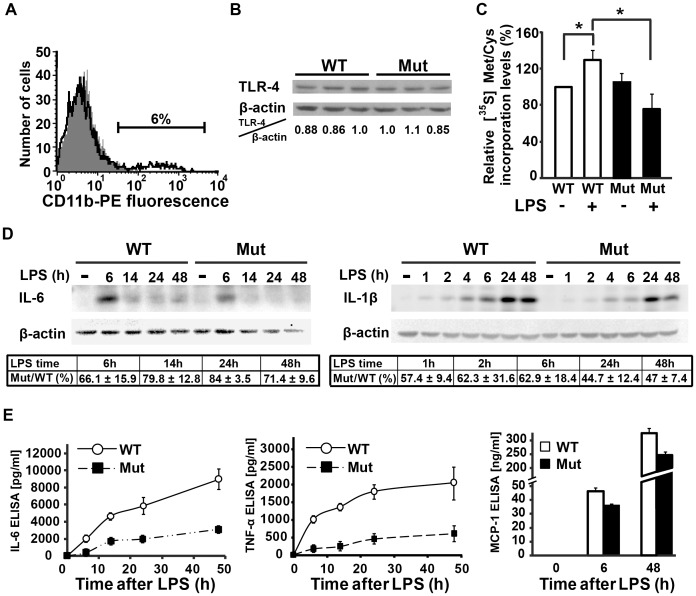
Activated primary astrocytes-microglia cultures from Eif2b5R132H/R132H mice do not exhibit increased global translation and display impaired production of cytokines.Primary mixed glia cultures were isolated from Eif2b5R132H/R132H (Mut) and wild-type (WT) mice. (A) Representative analysis of PE-labelled anti-CD11b staining followed by flow cytometry analysis. Both Mut and WT cultures contained 93–95% CD11b-negative (gray area) cells. (B) Immunoblot analysis of 3 independent experiments using anti-TLR4 and anti-β-actin antibodies. No statistically significant difference between WT and Mut cells was observed. (C) WT and Mut cells were treated with 2 µg/ml LPS for 48 h and metabolically labelled with [35S]L-methionine and [35S]L-cysteine for 30 min followed by determination of [35S]-Met/Cys incorporation following trichloroacetic acid precipitation. The incorporation level (cpm/µg protein) in untreated WT cells was set at 100%. Bars represent the means ± SEM of 3 independent experiments, *p<0.02. (D, E) WT and Mut cultures were incubated with 2 µg/ml LPS for the indicated times followed by cell harvest and media collection. A representative immunoblot analysis of intracellular IL-6 and IL-1β protein levels is shown and the average (of 3 independent experiments) of IL-6/β-actin and IL-1β/β-actin in Mut relative to WT is provided in (D); protein concentrations of IL-6, TNF-α and MCP-1 in the media was measured by ELISA and a representative of 3 independent experiments is shown in (E).